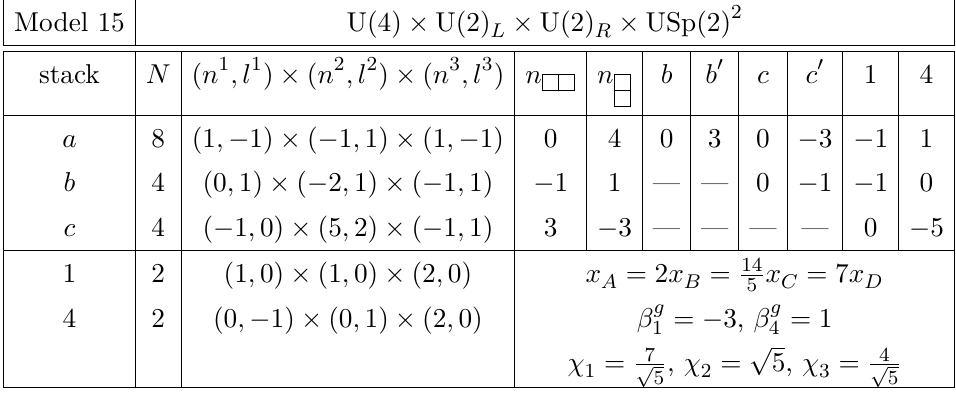
Table 22 . D6-brane configurations and intersection numbers of Model 15, and its gauge coupling